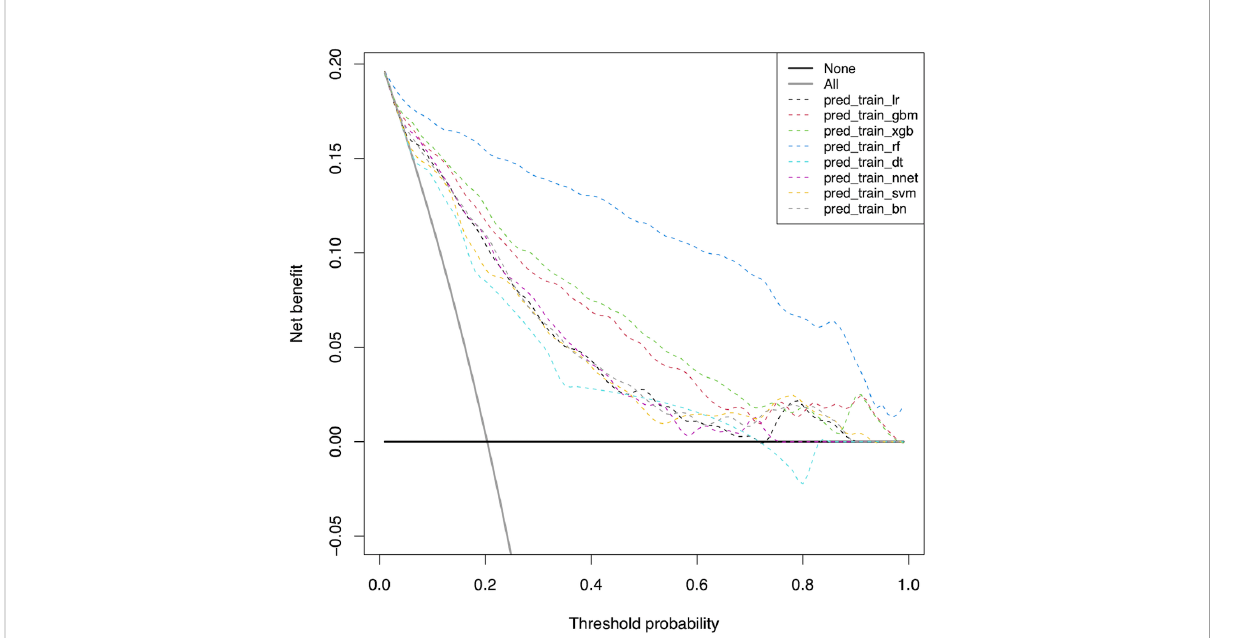
FIGURE 3 Decision curve for predictive models based on machine learning models in the training cohort. LR Logistic Regression; GBM Gradient Boosting Machine; XGB Extreme Gradient Boosting; RF Random Forest; DT Decision Tree; NNET Neural Network, SVM Support Vector Machine; BN Bayesian Network.